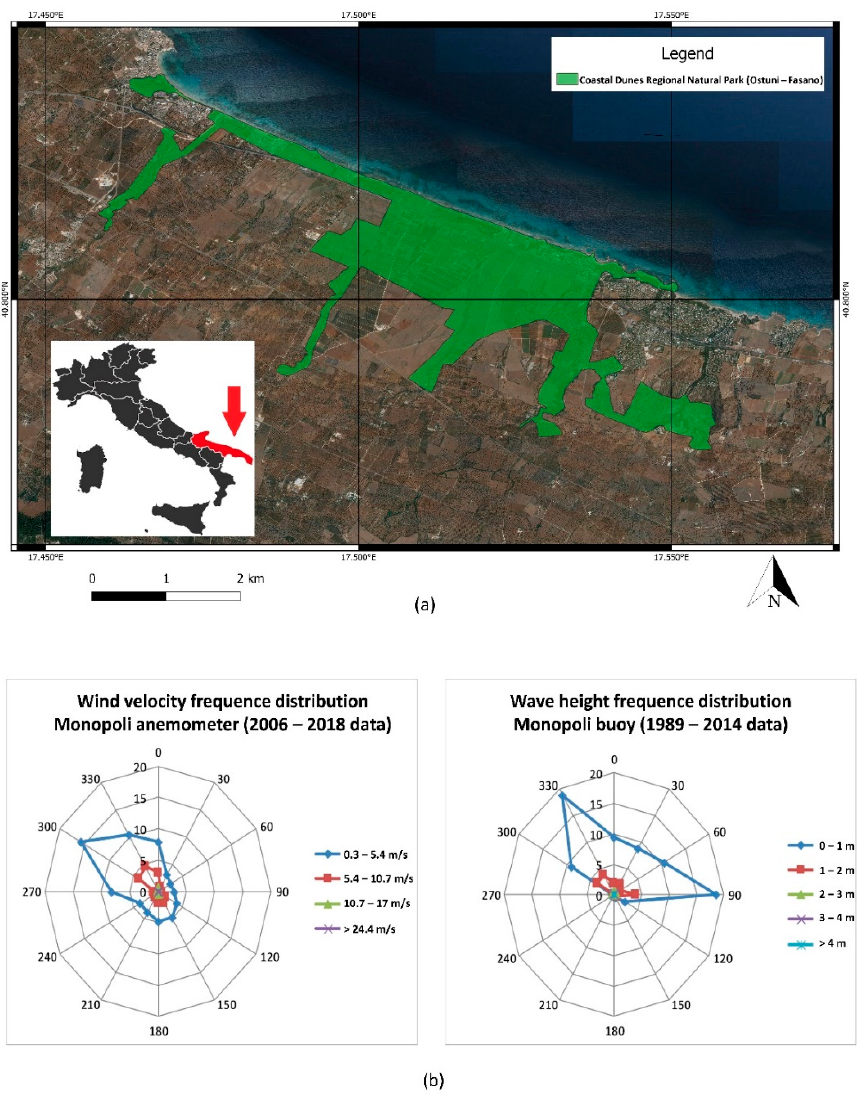
Figure 1. ( a ) Study area localization in the Coastal Dunes Regional Natural Park (Apulia, Italy); ( b ) Polar plots of the wind speed distribution and wave height distribution.